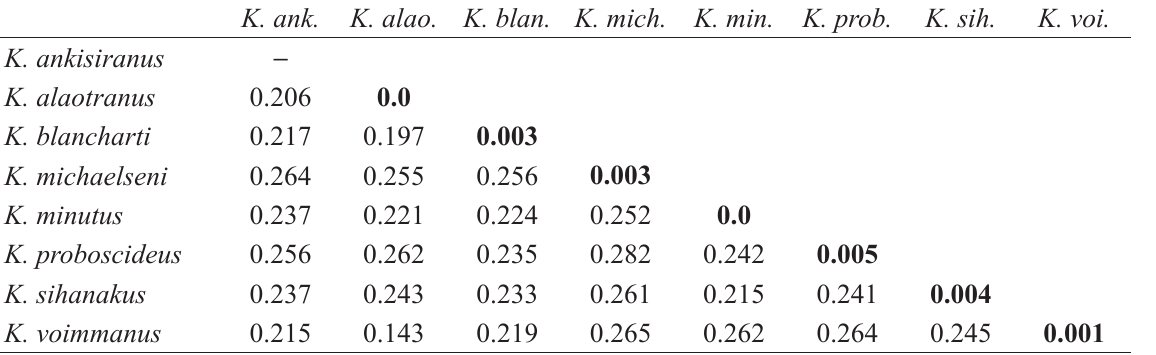
Table 3. Average interspecific (below the diagonal) and intra specific (bold, in the diagonal) K2P genetic distances of the species of Kynotus Michaelsen, 1891